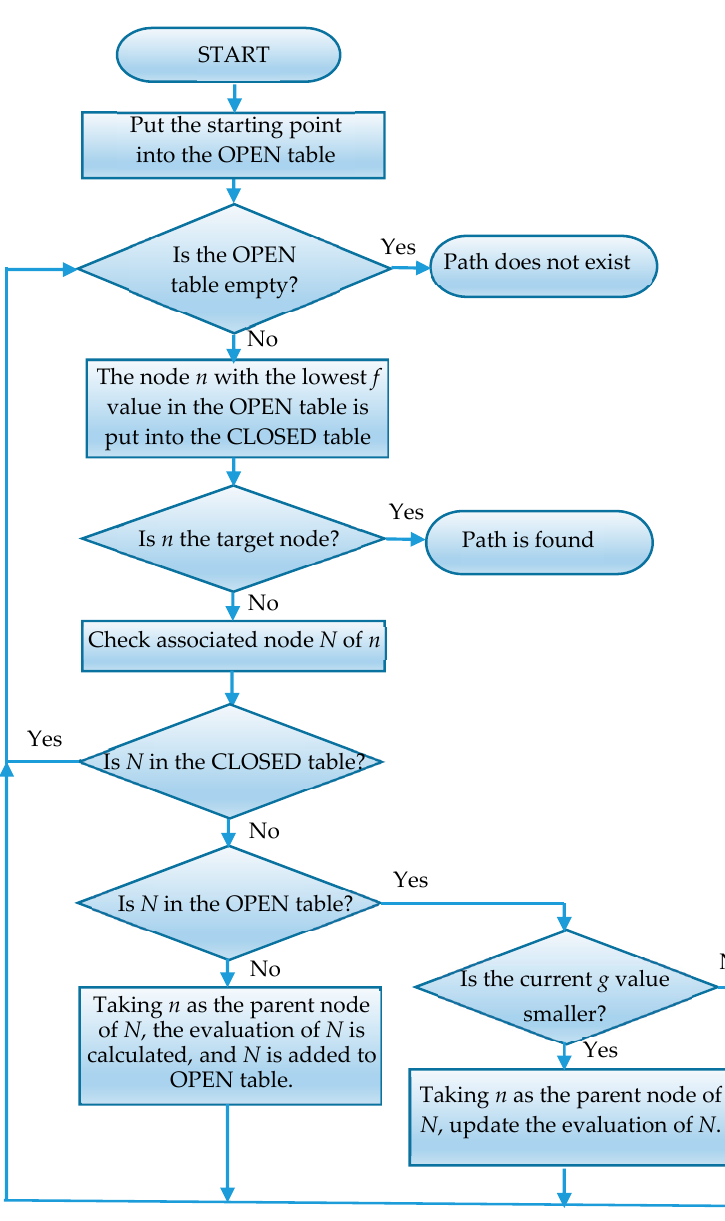
Figure 11. A* algorithm flowchart.